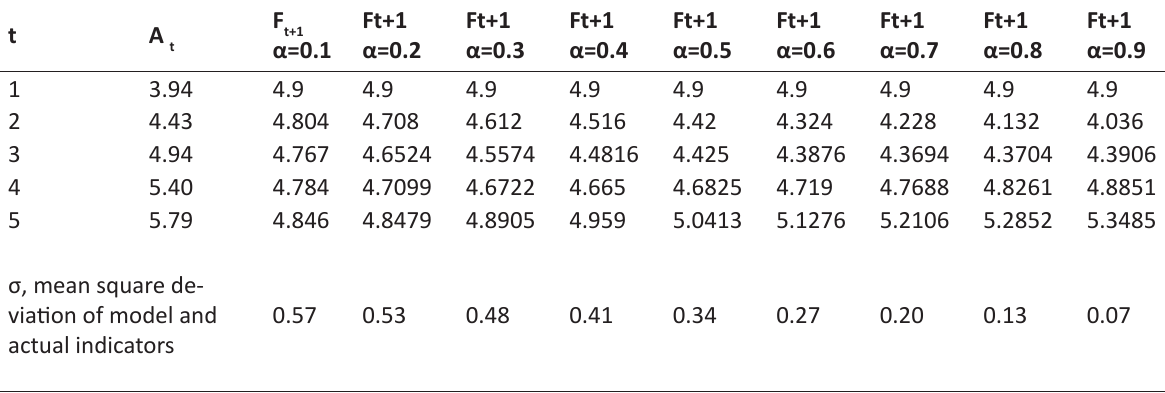
Table 8. Mean square deviations of model and actual indicators in control group in May